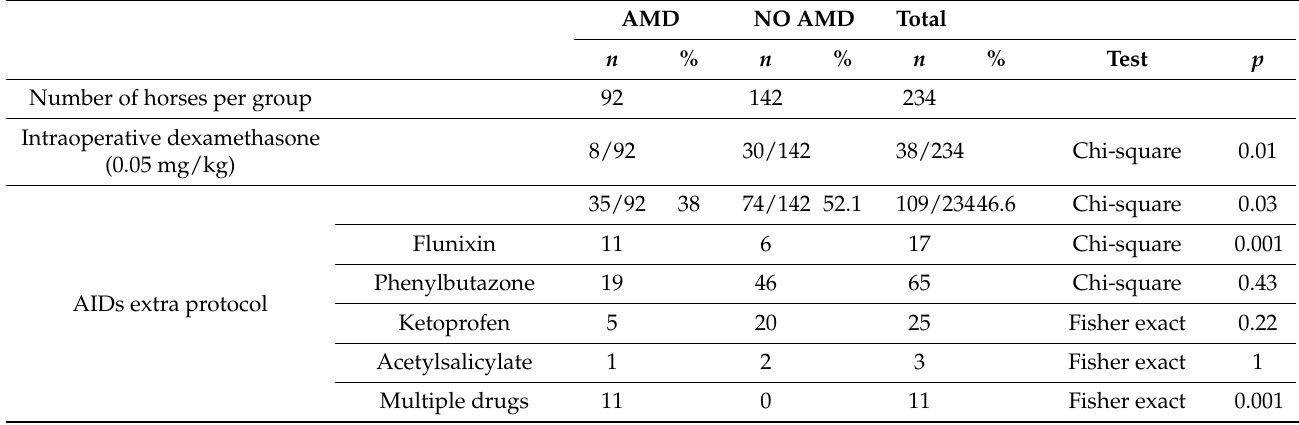
Table 3. Data of anti-inflammatory administration in the postoperative period and reason behind this approach (AIDs extra protocol: AIDs in addition to the AIDs administered as part of the